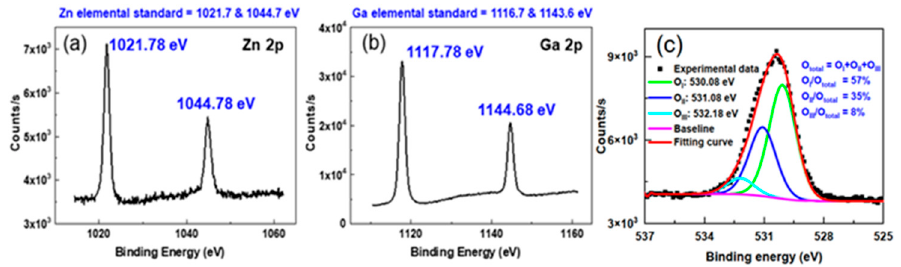
Figure 3. ( a ) Zn 2p, ( b ) Ga 2p and ( c ) O 1s XPS spectra of the ZGO thin film.